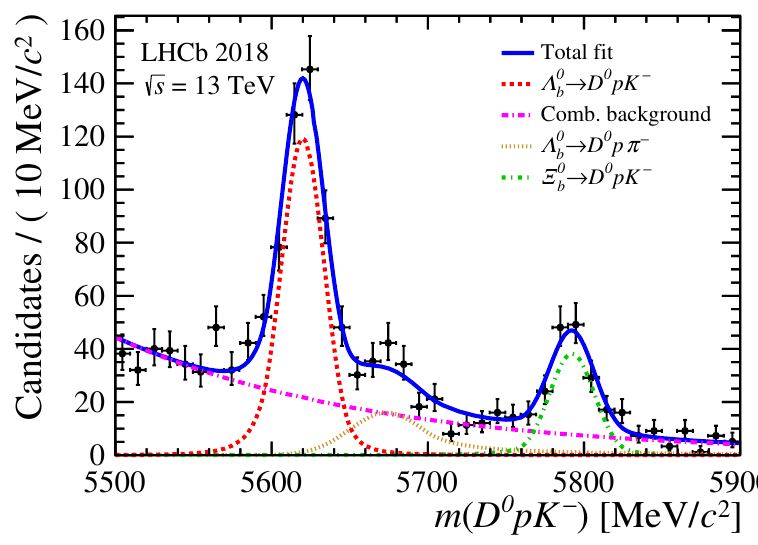
Figure 3 . Invariant mass distribution for (cid:3) 0 ! D 0 pK (cid:0) candidates in the 2018 data sample b (black points). The (cid:12)t projection (blue solid line) is superimposed. The normalisation component (red dashed line), the misidenti(cid:12)ed background (brown dashed line), the combinatorial background (purple dotted line), and the (cid:4) 0 ! D 0 pK (cid:0) (green dotted line) components are also shown. Similar b distributions are obtained for the 2016 and 2017 data